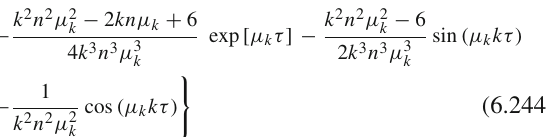
Fig. 43 EvolutionofprobabilitydistributionfunctionobtainedfromthefourthordercorrectedFokker–Planckequationwiththeoccupationnumber n for different value of m 4 . Here we use the initial conditions as mentioned in Eq.